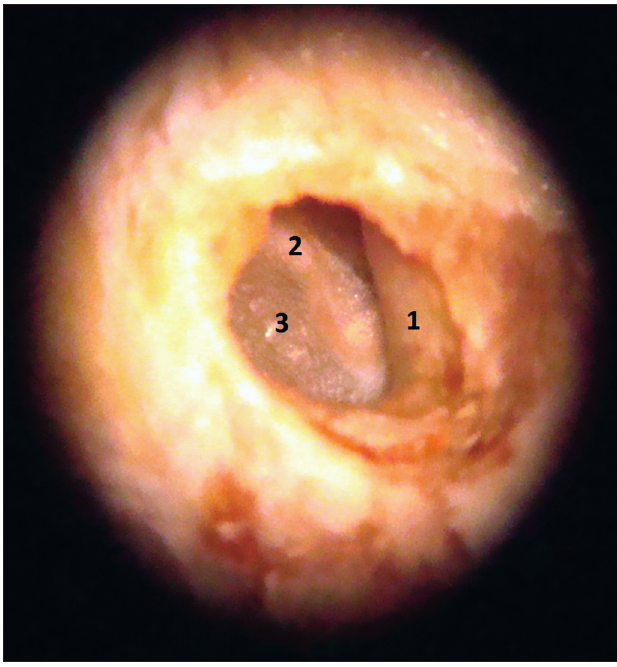
Figura 3. Imagem da peça vista pelo microscópio (aumento de 10x). 1: Meato acústico externo; 2: Cabo do martelo; 3: Camada